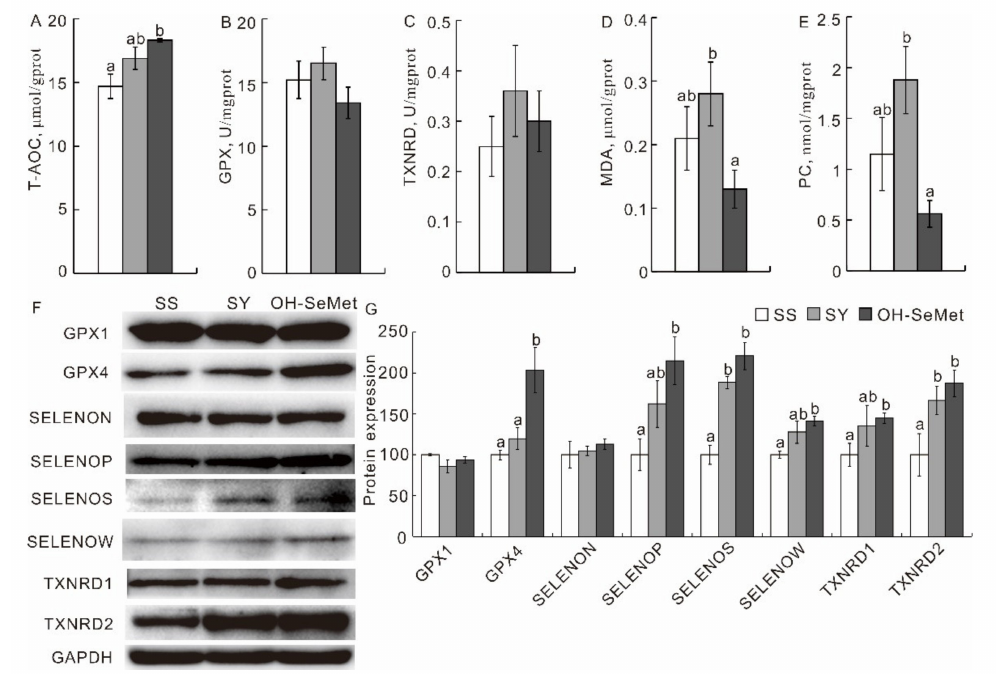
Figure 4. Effect of the three forms of Se on the T-AOC ( A ), GPX ( B ), TXNRD ( C ), MDA concentration ( D ), PC concentration ( E ), and protein production of GPX1, GPX4, SELENON, SELENOP, SELENOS, SELENOW, TXNRD1 and TXNRD2 ( F , G ) activities in the pectoral muscle of the broilers. The values are the means ± SE, n = 12 for the redox status, n = 3 for the western blot. Labeled means within the same plot without a common letter differ, p < 0.05. GAPDH, glyceraldehyde-3-phosphate dehy- drogenase; GPX, GPX1 and 4, glutathione peroxidase, 1 and 4; MDA, malondialdehyde; PC, protein carbonyl; SELENON, P, S, W, selenoprotein N, P, S, W; T-AOC, total antioxidant capacity; TXNRD, TXNRD1 and 2, thioredoxin reductase, thioredoxin reductase 1 and 2; SS, basal diet supplemented with 0.3 mg Se/kg as sodium selenite; SY, basal diet supplemented with 0.3 mg Se/kg as seleno-yeast; OH-SeMet, basal diet supplemented with 0.3 mg Se/kg as